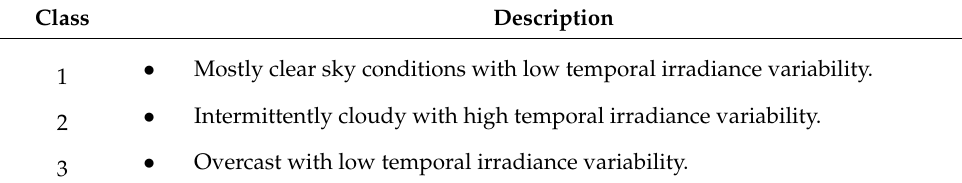
Table 4. DNI and GHI variability